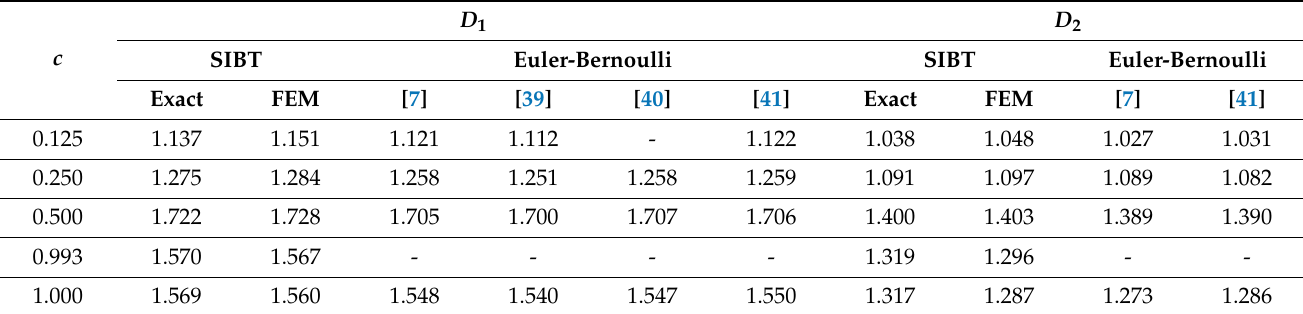
Table 3. D 1 and D 2 for different moving